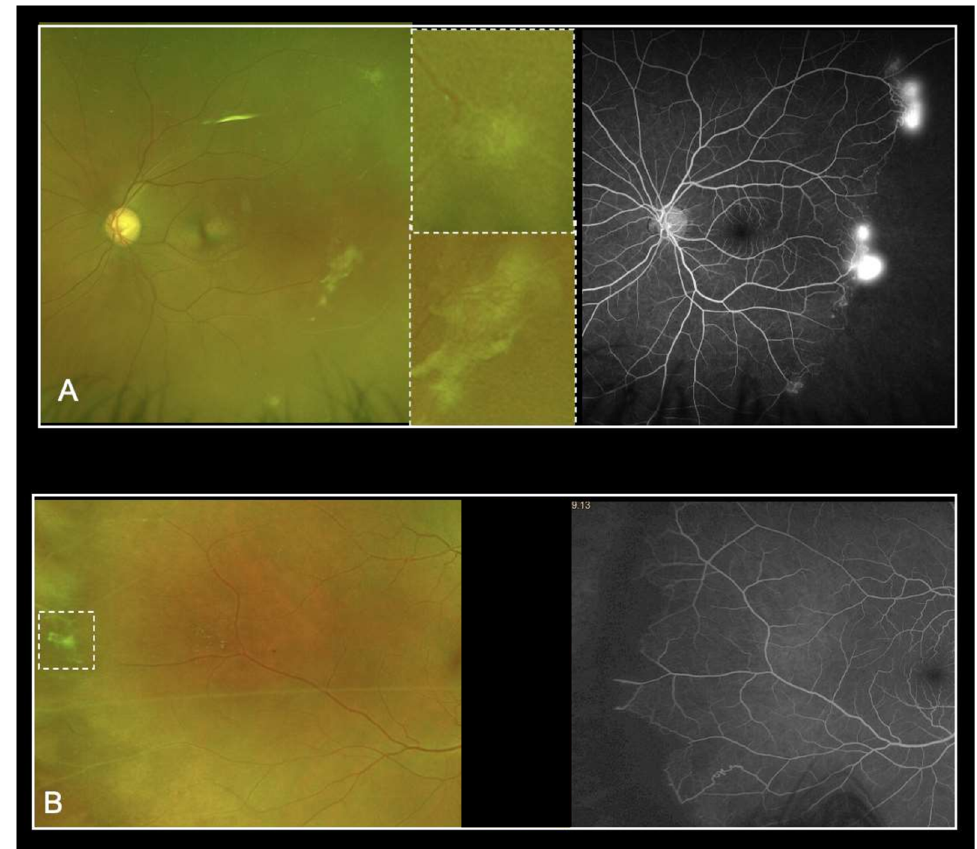
Figure 3. Sea fan lesions associated with retina fibrosis on UWF ‐ FP: UWF ‐ FA revealed persistent leakage ( A ) or complete sea fan fibrosis with no leakage ( B ).